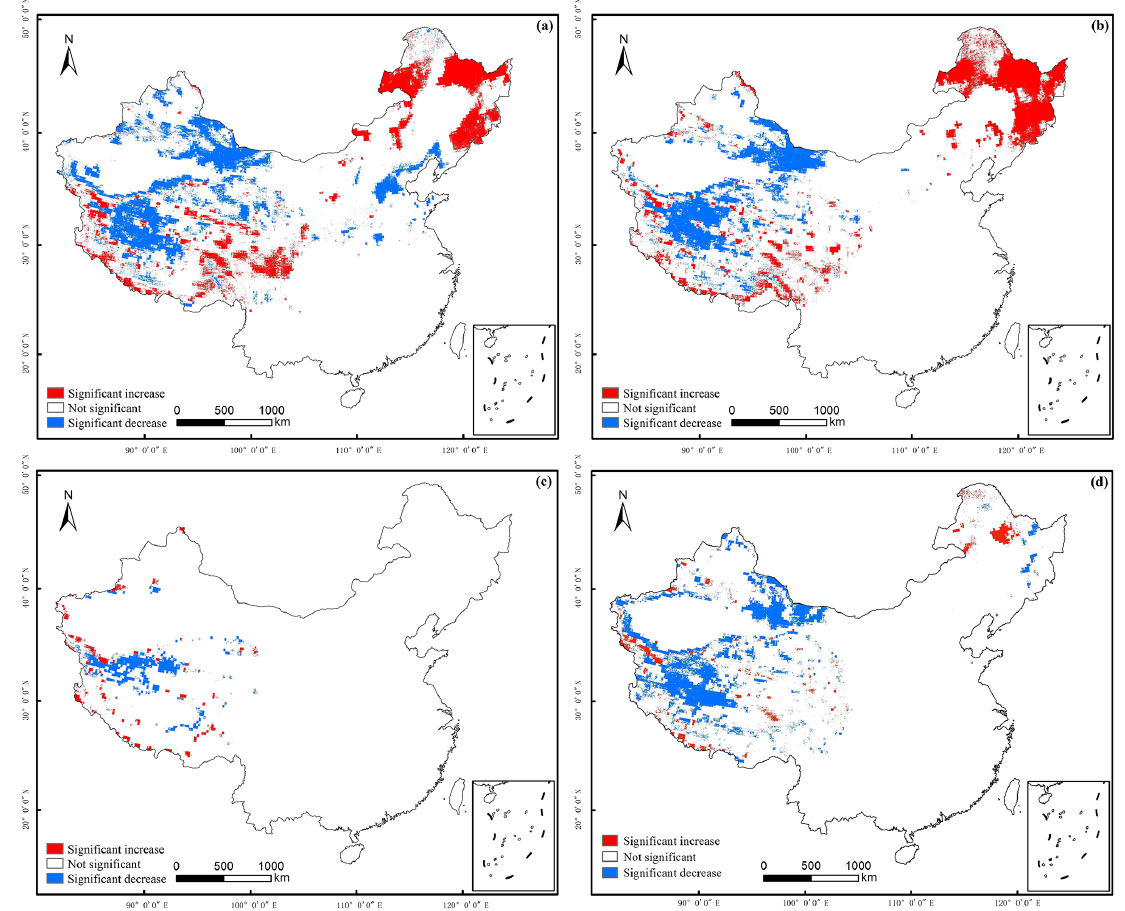
Figure 10. Variation in the average SD during each season in China based on the M–K method from 2001 to 2014. Panels (a) – (d) show the significance of the variations during the winter, spring, summer, and fall,